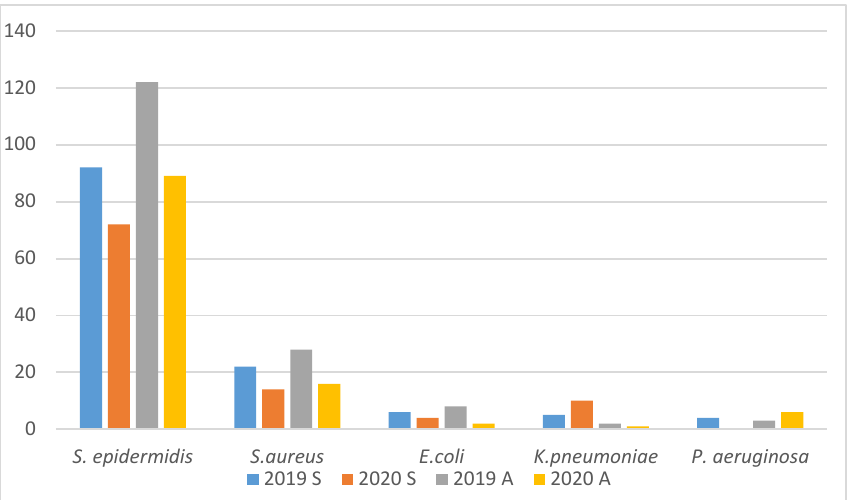
Figure 2. Pathogens found in blood cultures. Table 2. Pathogens found in blood cultures.